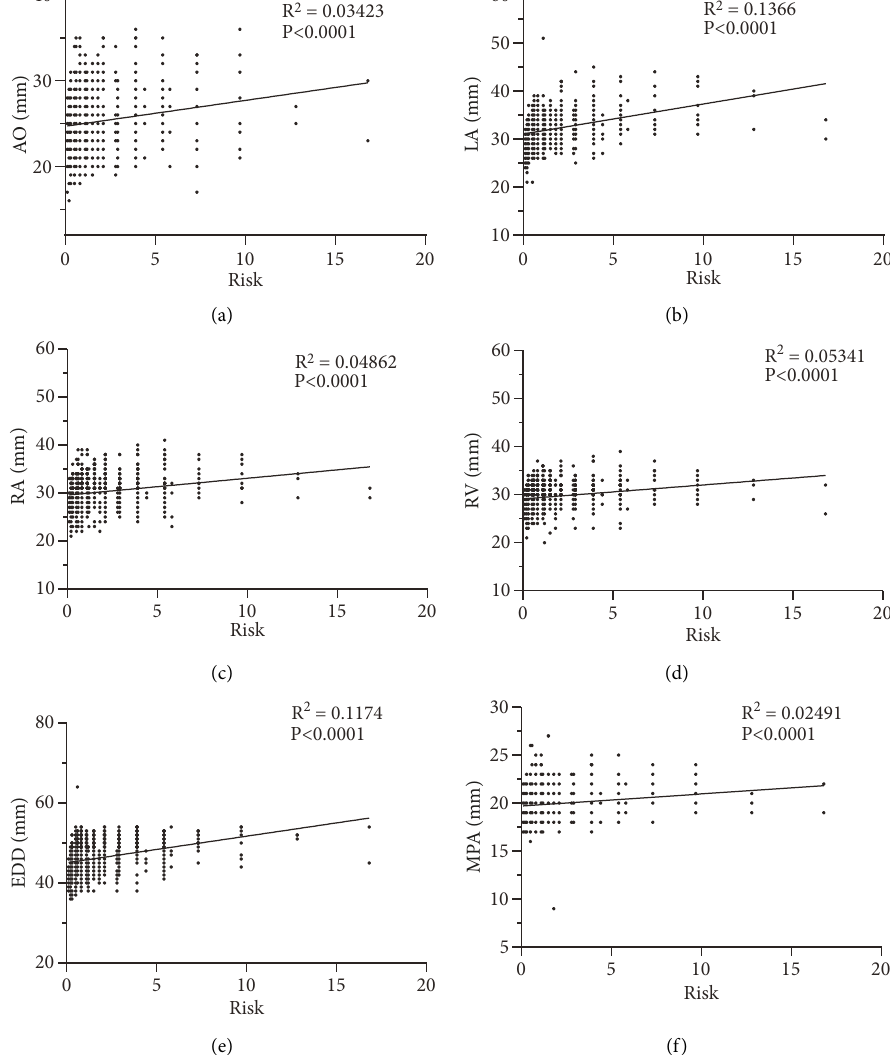
Figure 5: Correlation of cardiac ultrasound parameters with cardiovascular risk. (a) Aorta (AO). (b) Left atrium (LA). (c) Right atrium (RA). (d) Right ventricle (RV). (e) End diastolic diameter of left ventricle (EDD). (f) Main pulmonary artery